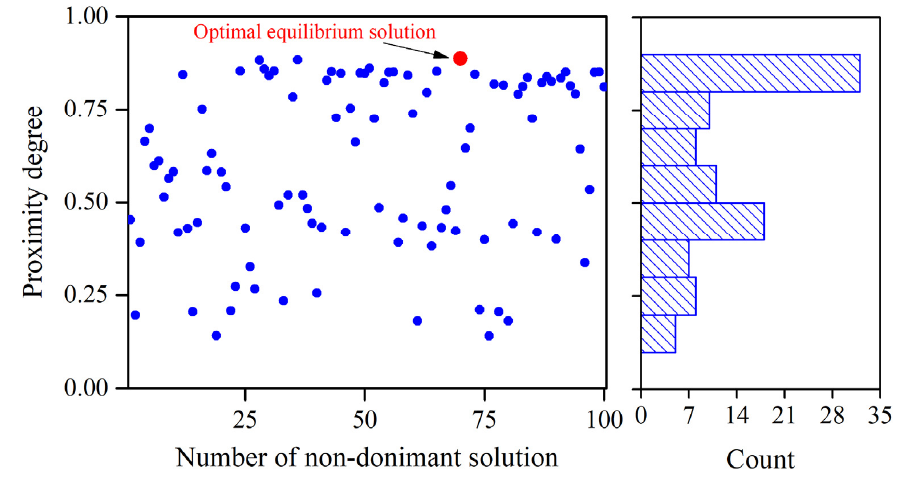
Figure 5. Scatter plot of proximity degree derived from non-dominated